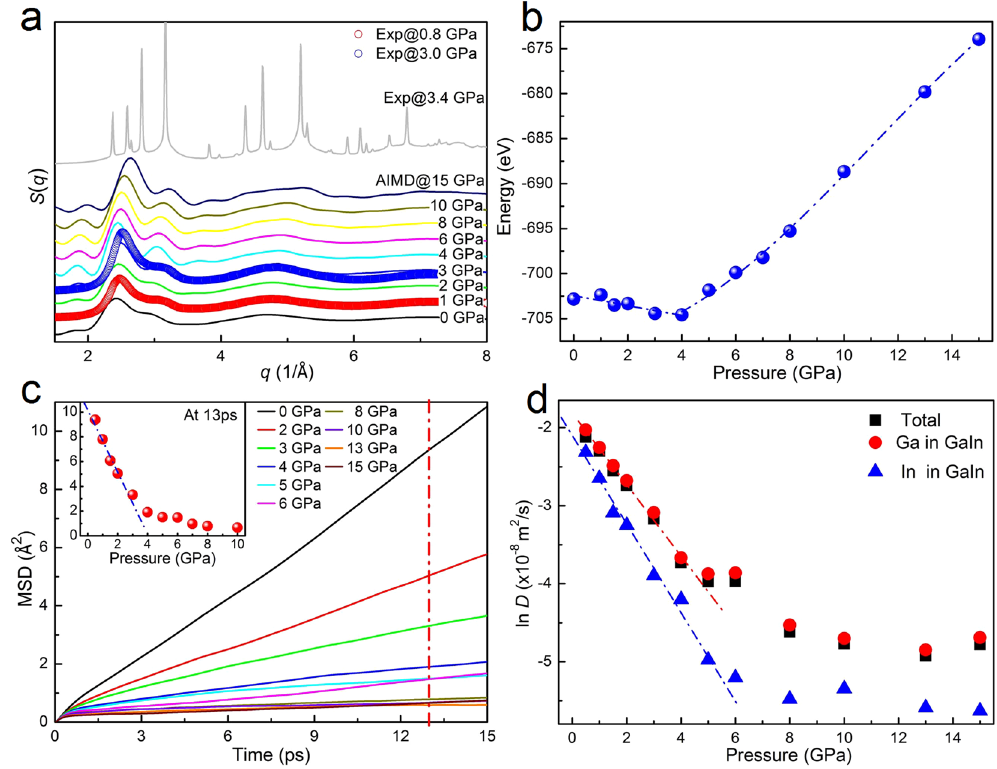
Figure 4. Structural information and dynamic behaviors of Ga 86 In 14 alloy obtained from AIMD method. ( a ) Comparison of the calculated and experimental total structure factor S ( q ) at selected low-pressures. ( b ) The pressure-energy relation of GaIn alloy. ( c ) Time dependence of the mean square displacement (MSD) with pressure, the left inset showing the MSD located at 13 ps. ( d ) Self-diffusion coefficients, D , for total, Ga and In atoms, respectively.